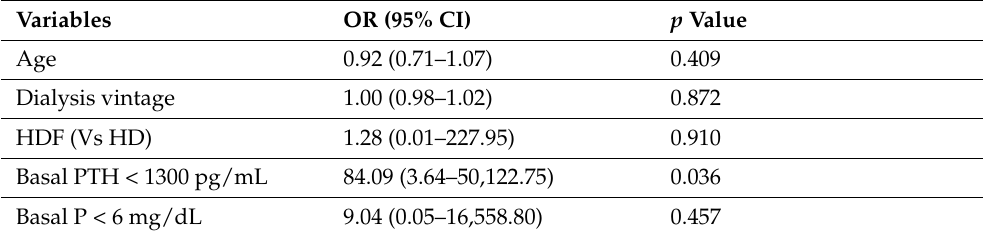
Table 8. Multivariate logistic regression to achievement of PTH reduction endpoint ≥ 40% at 6 months. OR, odds ratio; CI, confidence